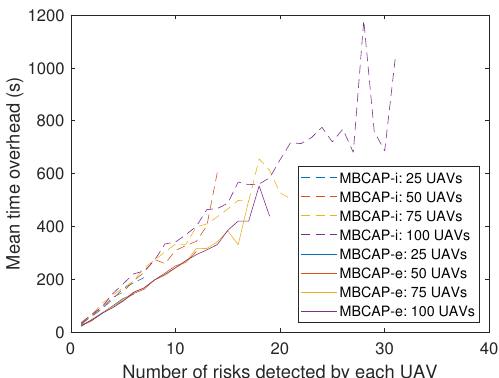
Figure 18. MBCAP-i vs. MBCAP-e: Global time overhead given the risks detected by each UAV.